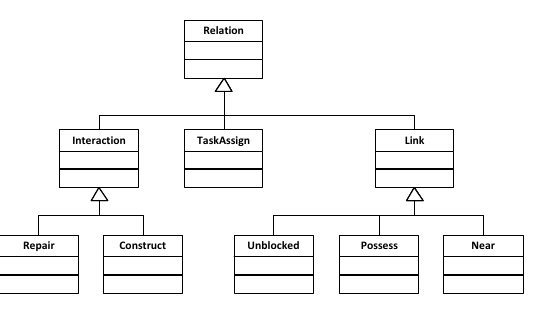
Figure 4. Meta Model of Relation